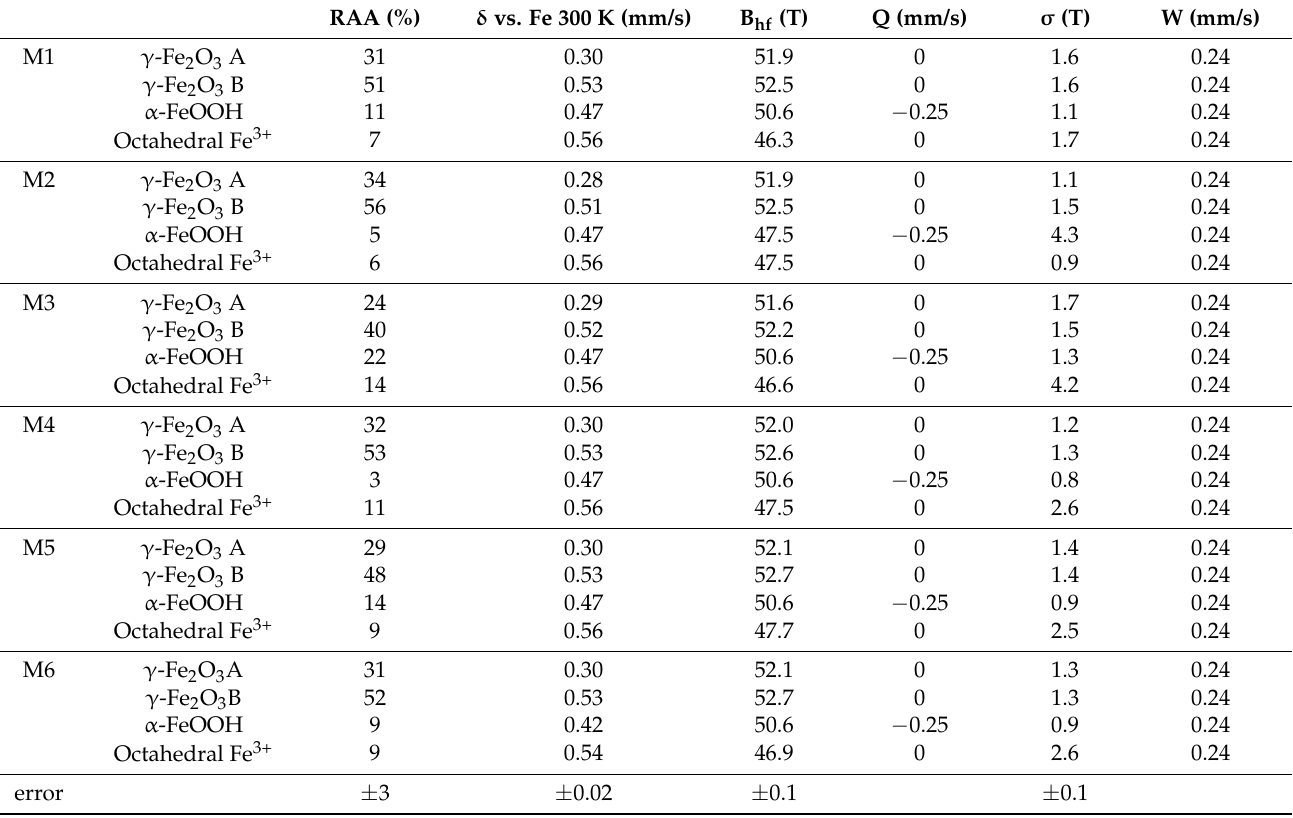
Table 2. Hyperfine parameters for the M samples at 15 K. RAA: relative spectral absorption area; δ : isomer shift vs. Fe at 300 K; B hf : Magnetic hyperfine field; Q: quadrupole splitting (fixed); σ : width of Gaussian distribution of B hf ; W: Lorentzian width (fixed).